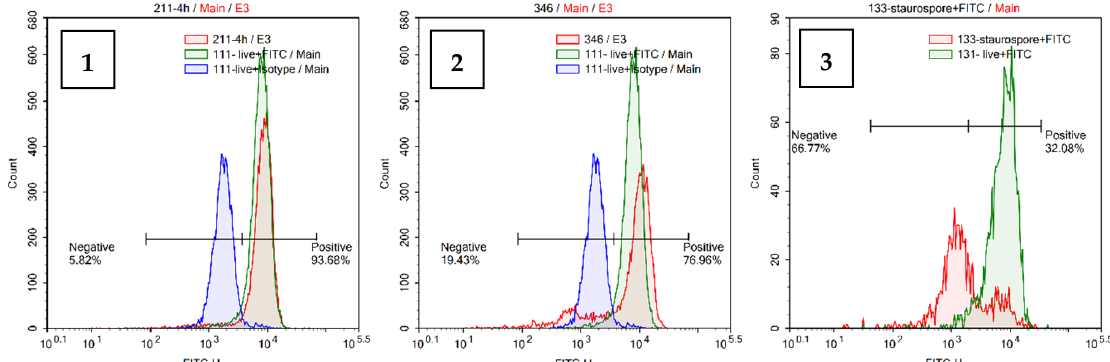
Figure 4. Histograms depicting cells stained using the FlowCellect Cytochrome C Kit. ( 1 ) shows untreated Jurkat cells; ( 2 ) shows cells treated with compound 24d ; ( 3 ) shows cells induced with staurosporine (1 µM) for 2 h. The graphs show the downward fluorescence shifts of cytochrome c levels for several cell lines and inducers for the FlowCellect Cytochrome c Kit. Histogram plots show live cells (negative control) and cells stained with cytochrome c-FITC. Cells stained with cytochrome c-FITC demonstrate high fluorescence. They are cells with intact mitochondria. Cells which exhibit reduced fluorescence undergo membrane disruption by the test compound, resulting in a loss of cytochrome C.